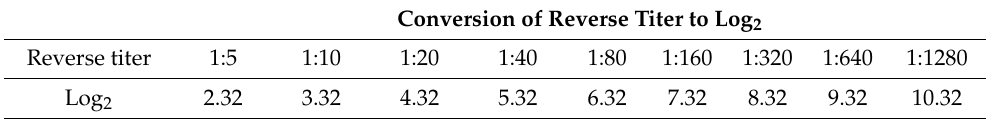
Table 1. Logarithmic titer data in reverse